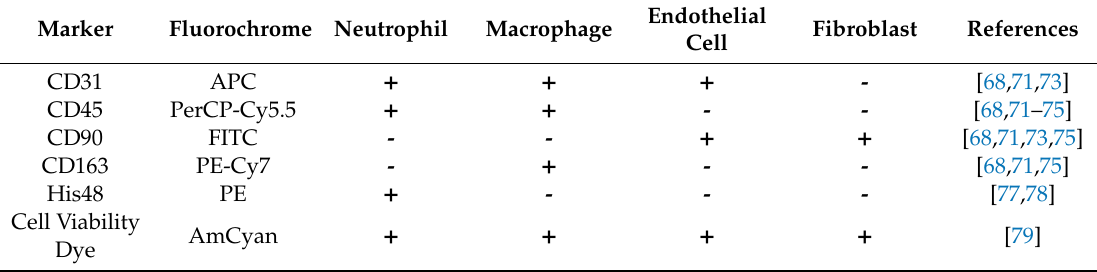
Table 3. Rat cell surface marker profile for flow cytometry in Panel B. “ + ” shows positive expression and “-” shows negative